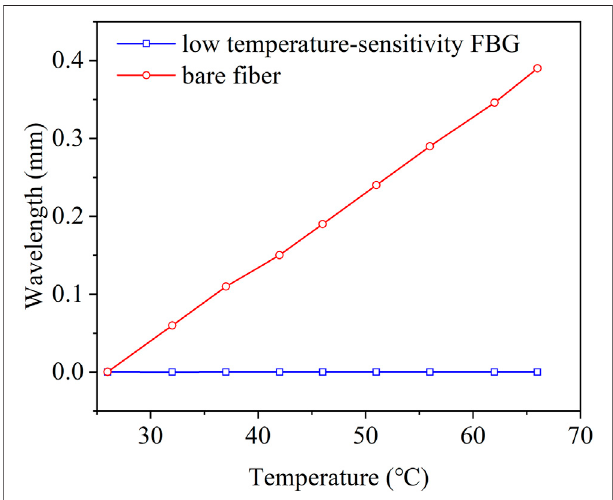
FIGURE 5 | Results of the low temperature sensitivity tests.